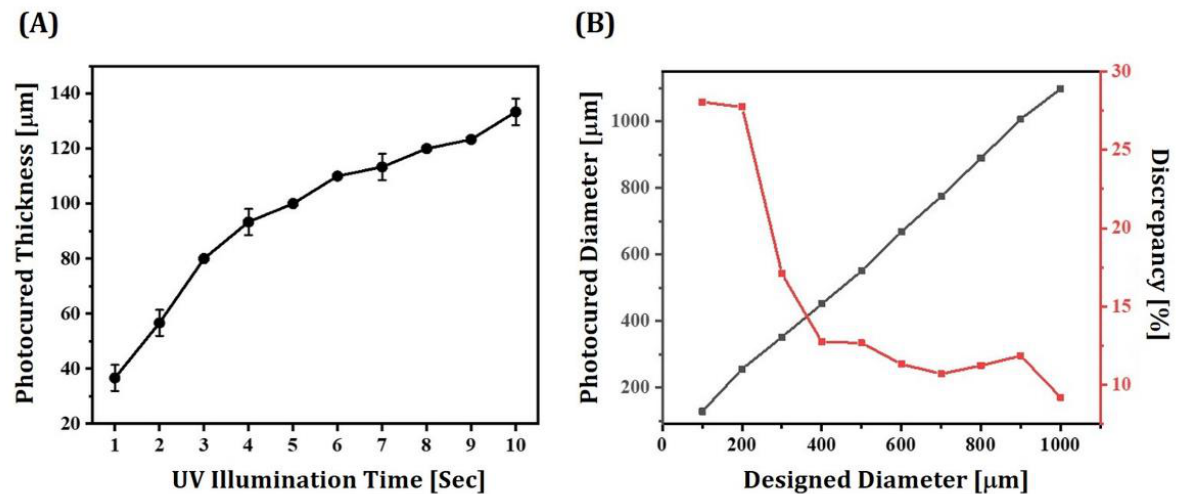
Figure 9. ( A ) Thicknesses of photocured layers obtained using a range of UV illumination time (1 s–10 s) and ( B ) diameters of photocured disks in regard to designed diameters and percent (%) discrepancies between measured and initial values. The black and red symbols in Figure 9B represent photocured diameters and discrepancies, respectively.